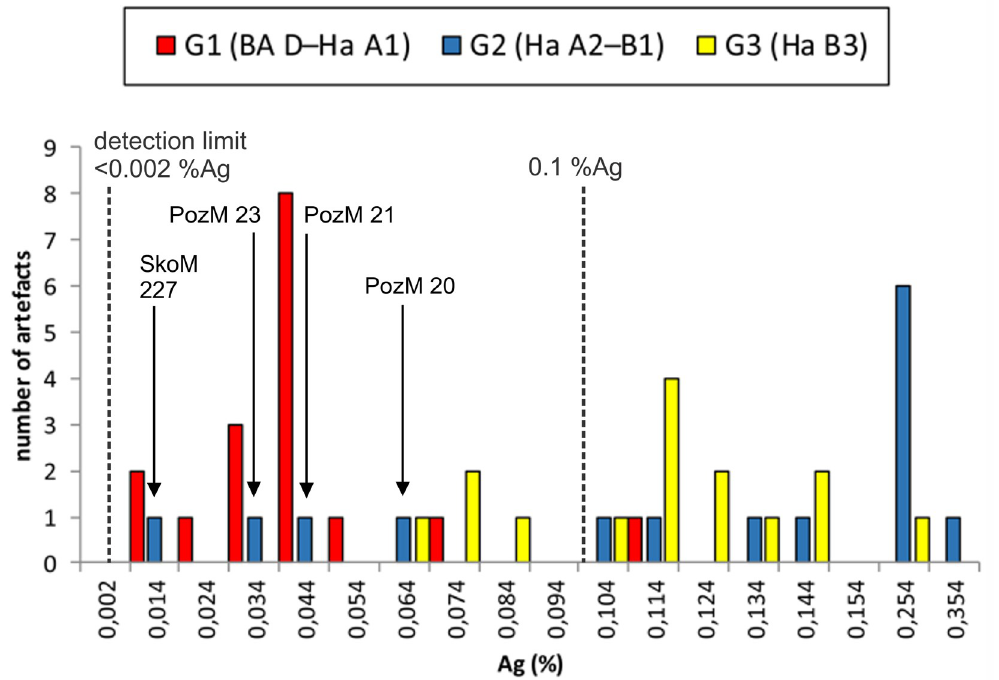
Fig 7. Silver concentration of the objects presented in this study, subdivided by chronology. Silver concentration in the 45 pieces under study. The two peaks at 0,044% and 0,254% represent two types of copper (n = 45). Note that the chronological group Ha A2–B1 (blue columns) contains four objects, which are dated to BA D–Ha A1 (red columns) by typology, but were found in younger contexts. They are geochemically consistent with pieces assigned to the older phase BA D–Ha A1. All values are given in weight % (chart: M. Mehofer, University Vienna).